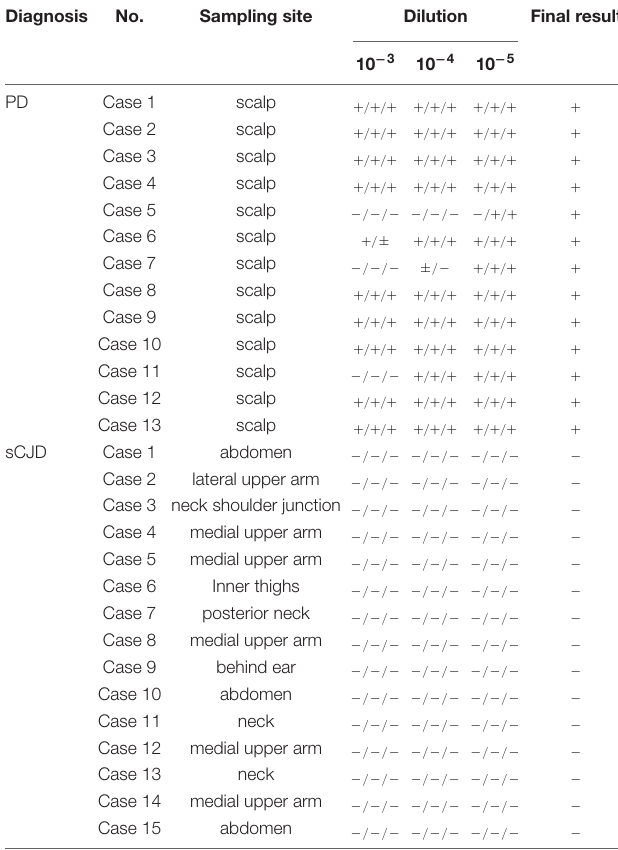
TABLE 3 | The results of the skin samples in per well at the different dilutions from patients with PD and sCJD. Diagnosis